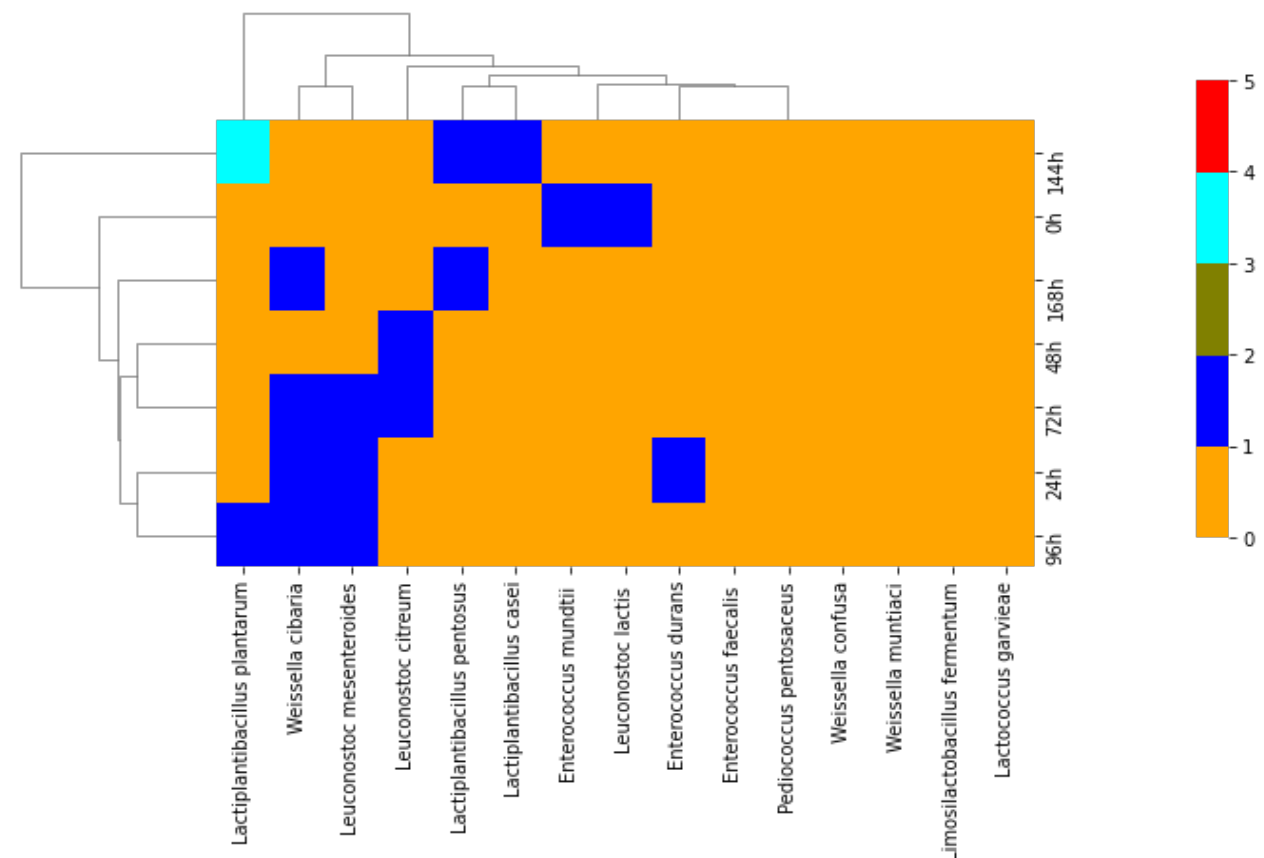
7 colored scale bar indicates the significant quantified strength of the various African vegetables. The red color in the heatmap indicates the highest, and pink indicates the lowest significance at p ≤ 0.05 for the assayed treatments. Analysis of the relationship among the lactic acid bacteria species against different fermentation times in cowpea showed three cluster groups of the bacterial species. Addi- tionally, there was a relationship between 24 h and 96 h and 48 h and 72 h. There was no relationship at 0 h, 144 h, and 168 h. At 144 h, the highest number of bacterial species was